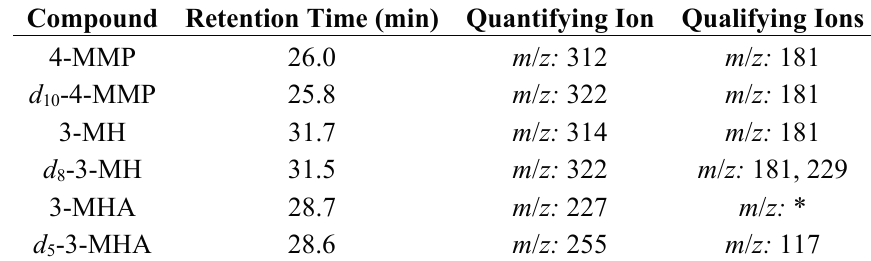
Table 4. Retention times and quantification and qualification ions for thiol–pentafluorobenzyl (PFB) derivatives and their internal standards.